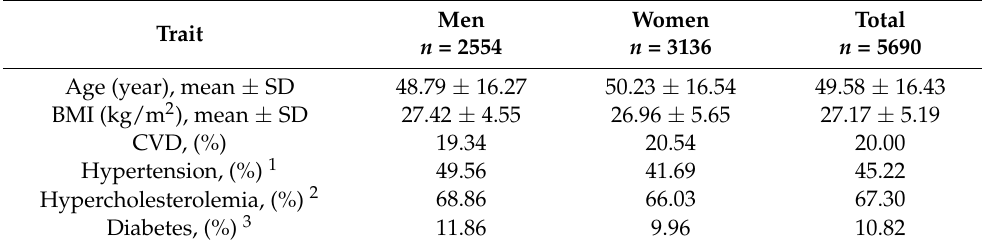
Table 1. General characteristics of the studied population.